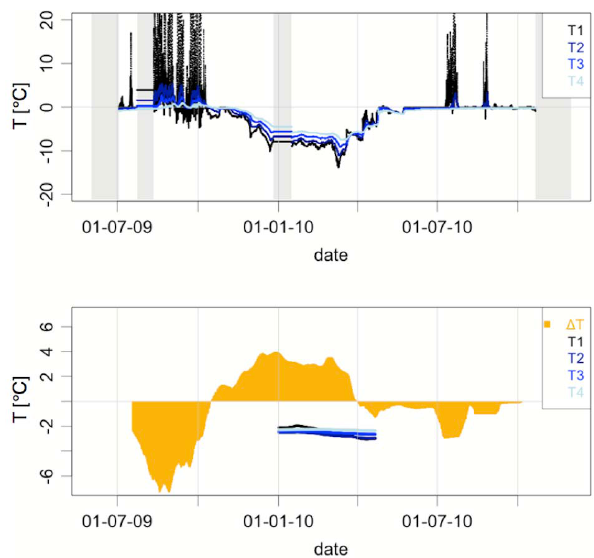
Fig. 12. Time series of jj01 with measured temperatures (top) and the temperature difference 1 T averaged over 30 days as well as MATs (bottom). Jj01 is a sensor rod at a location that accumulates